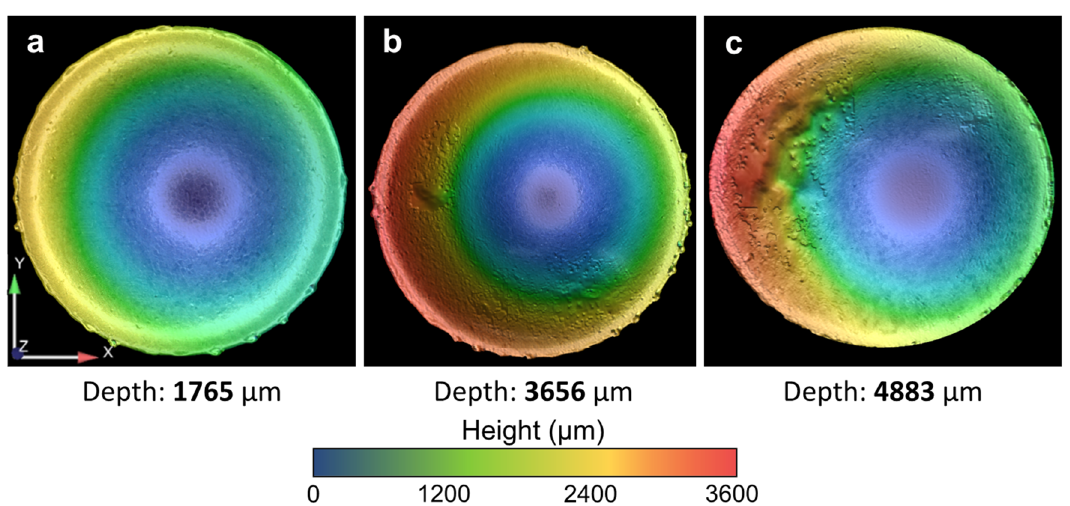
Figure 9. Morphology of the Ti64 electrode end surface after PREP under the operating conditions corresponding to the cases in Fig. 5 with gas flow rates of ( a ) 0, ( b ) 70, and ( c ) 160